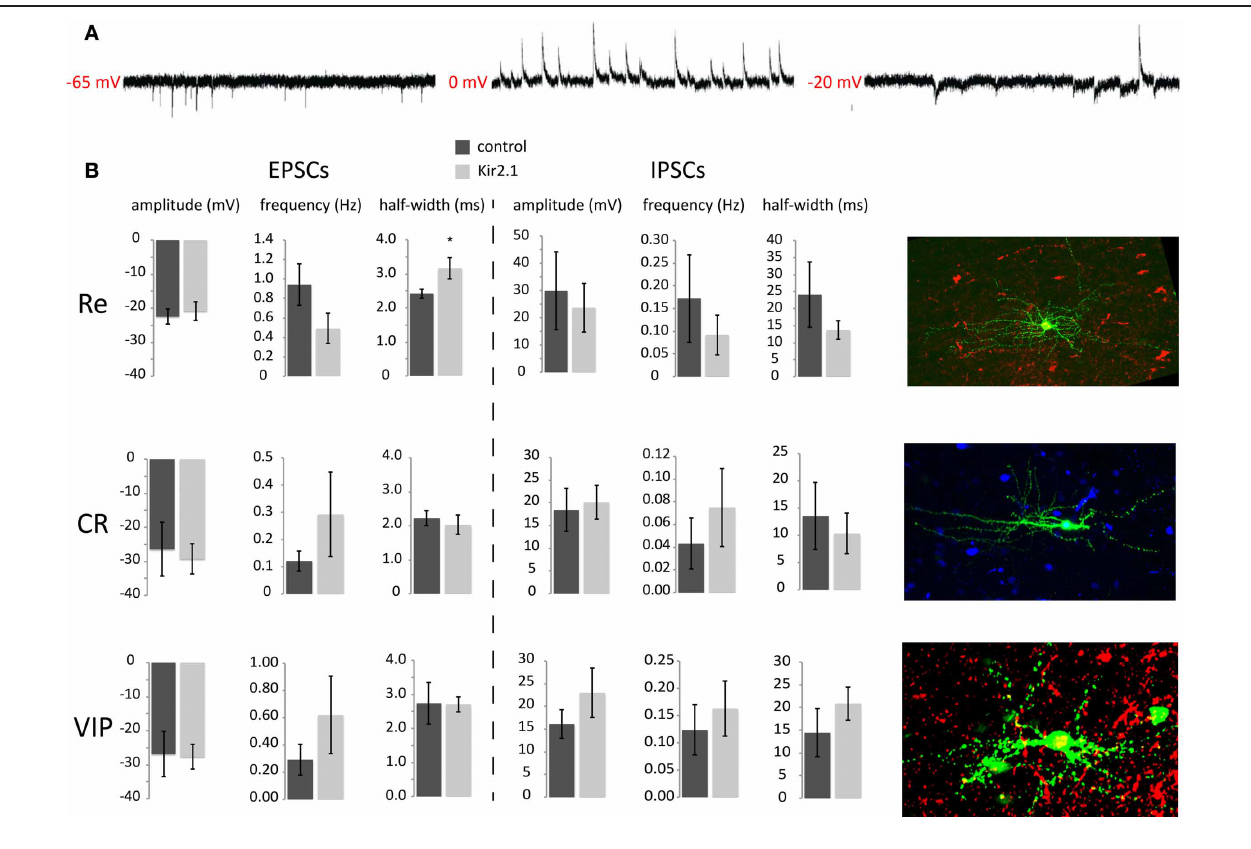
FIGURE 2 | Analysis of synaptic input onto e15.5-born CGE-derived GFP + interneurons at P8/9 (A) Example traces of sEPSCs, sIPSCs and both, recorded at − 65mV, 0mV, and − 20mV, respectively. (B) Analysis of the sEPSC and sIPSC characteristics for the three different groups recorded, Re − , CR − , and VIP-positive interneurons